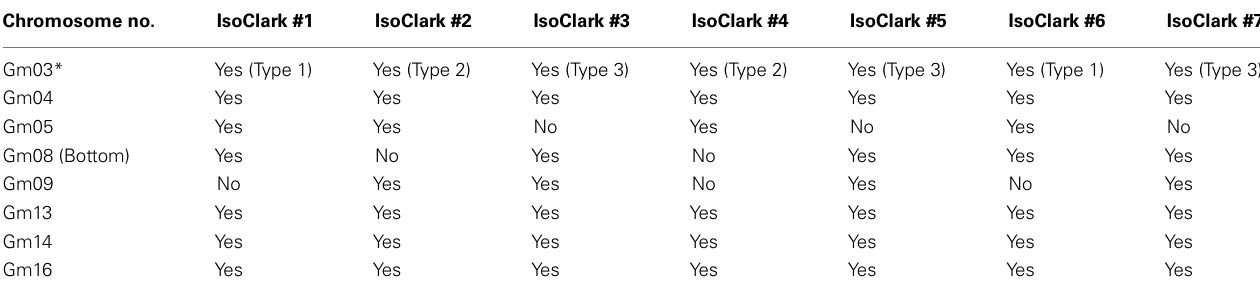
Table 3 | Frequency and presence of introgressed regions within seven sub-lines of IsoClark. Chromosome no.